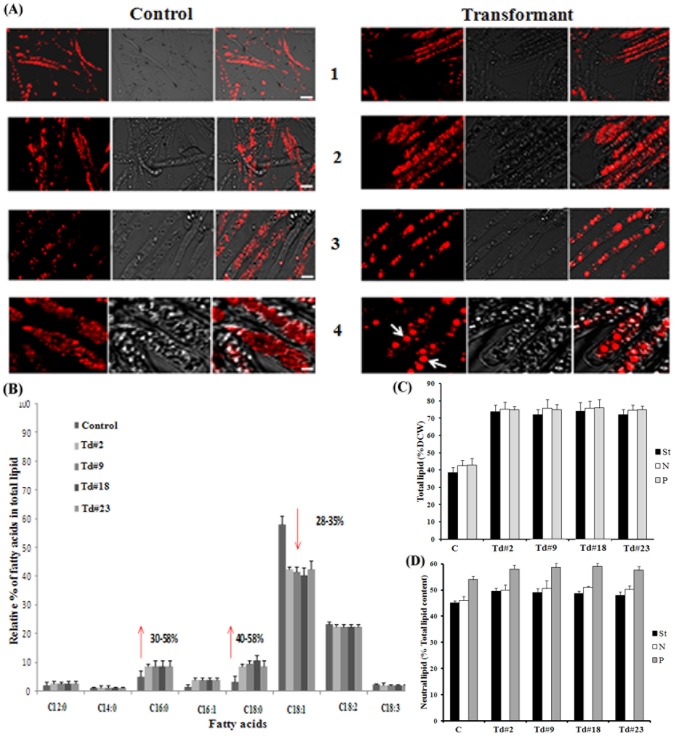
Alteration in the quality and quantity of storage lipid due to functional activity of CtDGAT2b in Colletotricum transformants.(A) Nile red stained confocal microscopic images of mycelia of the wild-type (control) and one of the transformed lines (Transformant). Panels 1 to 4 represent microscopic images of mycelia at different magnifications, and each panel has identical scale bar for both the control and transformant. In panels 1 and 2, scale bar  = 10 µm showing same magnification but at different location of mycelia. In panels 3 and 4, scale bar  = 5 µm and 2 µm, respectively. White arrow indicates increase in size of lipid droplets in mycelia of transformant. (B) Bar diagram representing fatty acid profile (relative % of fatty acids) in total lipid samples obtained from the wild-type and four transformants as revealed by GC-FID analysis. (C) Bar diagram showing total lipid content expressed as % of dry cell weight (% DCW) during standard growth condition (black bar), nitrogen starvation (white bar) and phosphorus starvation (grey bar) among the wild type control (C) and four (Td#2, Td#9, Td#18 and Td#23) fungal transformants. (D) Bar diagram depicting neutral lipid content expressed as % of total lipid content during above-mentioned three growth conditions among the wild type control (C) and the same four fungal transformants.